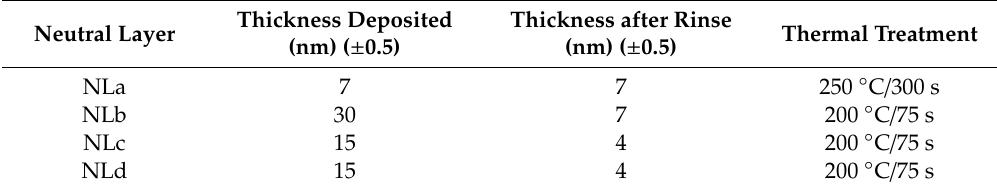
Table 1. Experimental parameters used for the neutral layer